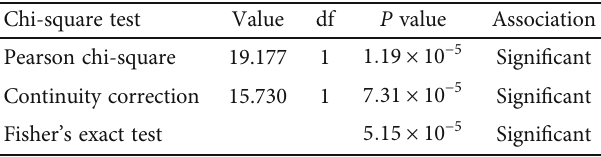
Table 1: Association among the cases between duration of mechanicalventilation ≥ 7days and fl uid balance ( ≥ 15%).